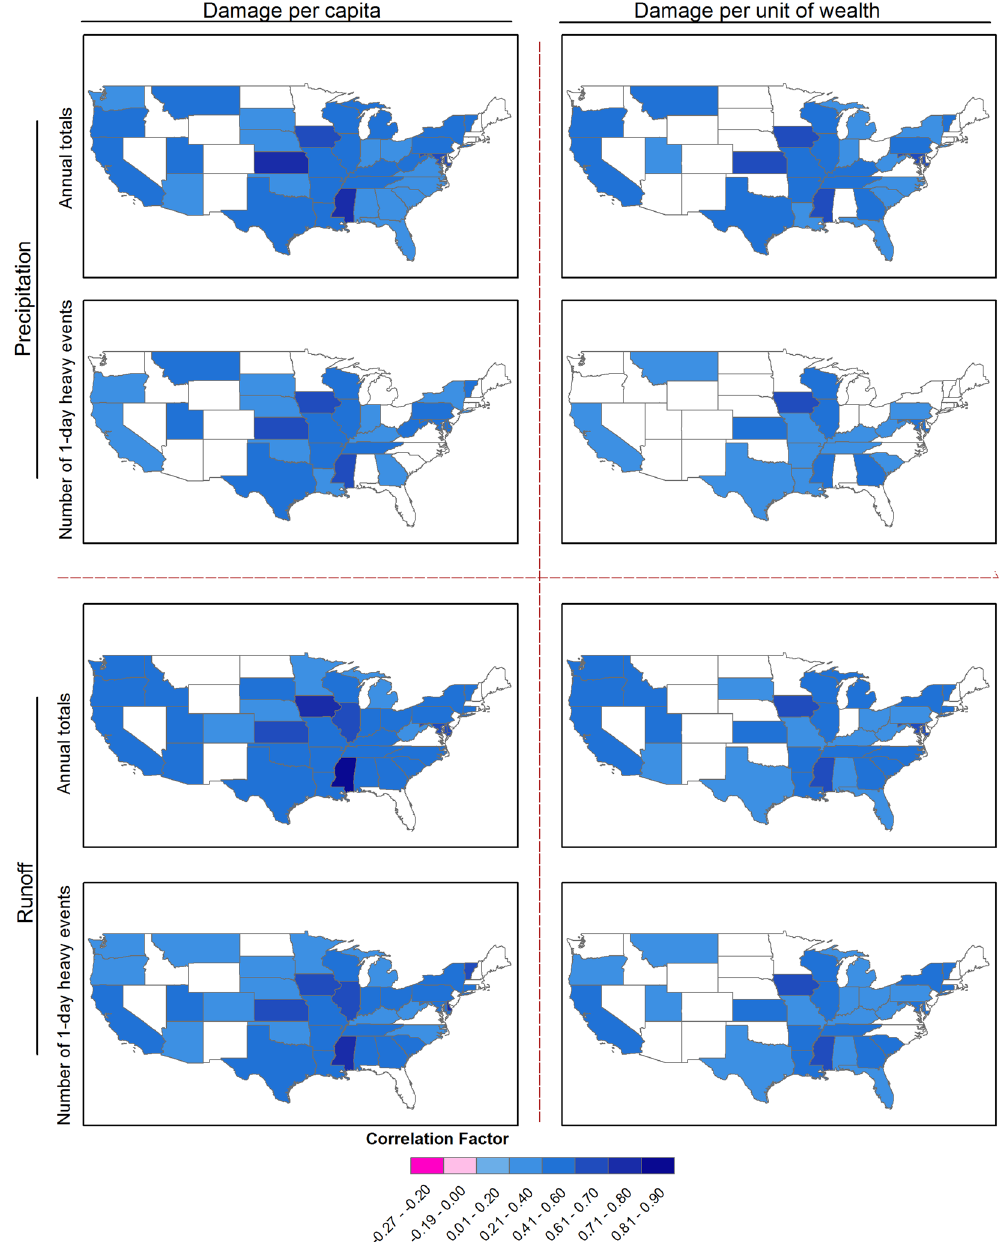
Figure 5. Correlation coefficient between hazard (indicated by annual total and extreme precipitation and runoff) and log-transformed Damage per capita (DPC) and Damage per unit of wealth (DPW). Only states where statistically significant relations are found at the 90% confidence level are shown. Figure was created using software ArcGIS 10.1